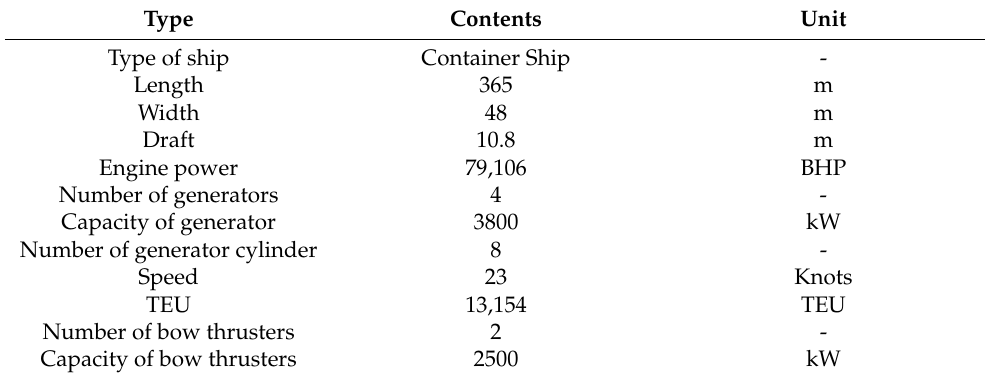
Figure 1. Power system of the target container ship. Table 1. Specifications of the target ship.